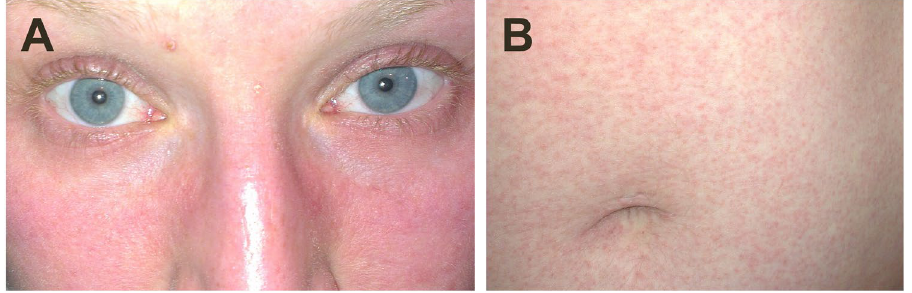
Figure 1. Photographs of ( A ) erythema in the face and slightly engorged blood vessels in the eyes, and ( B ) non- itching maculopapular rash on the abdomen of the patient from which ZIKV SL1602 was